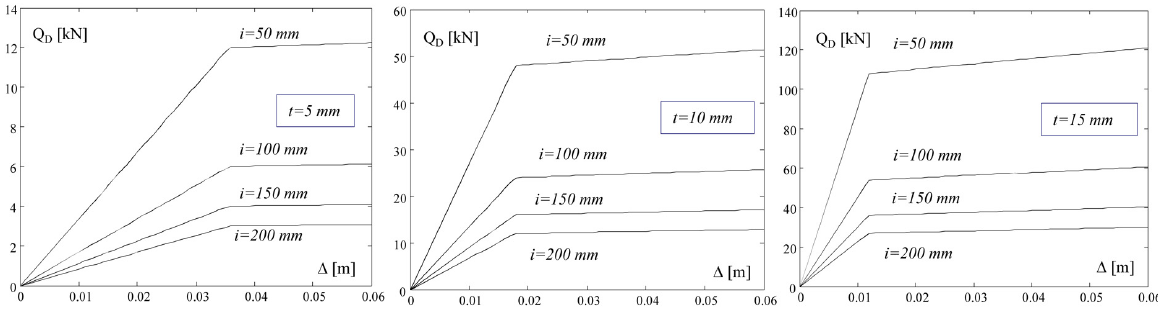
Figure 4. Model A: parametric analysis for different values of i and t